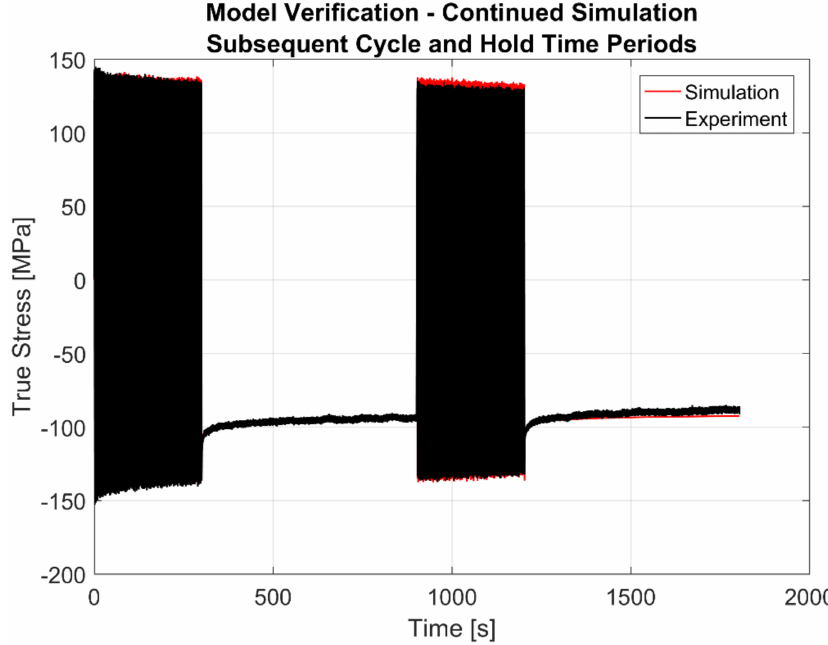
Figure 27. Simulation of continued loading of the second cycle and hold times for verification at 250 ◦